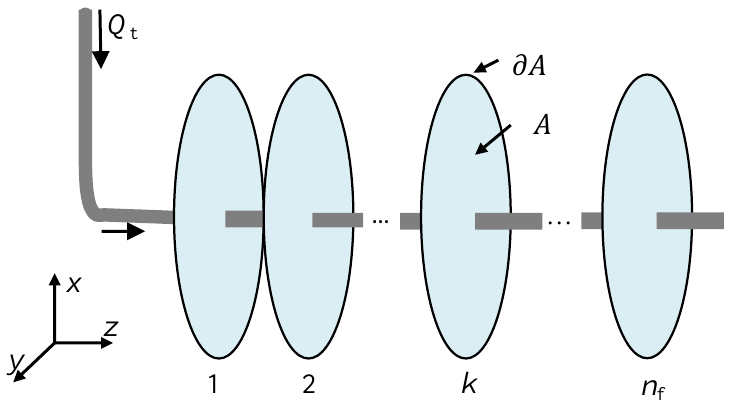
Figure 1. Schematic diagram of the geometric model.